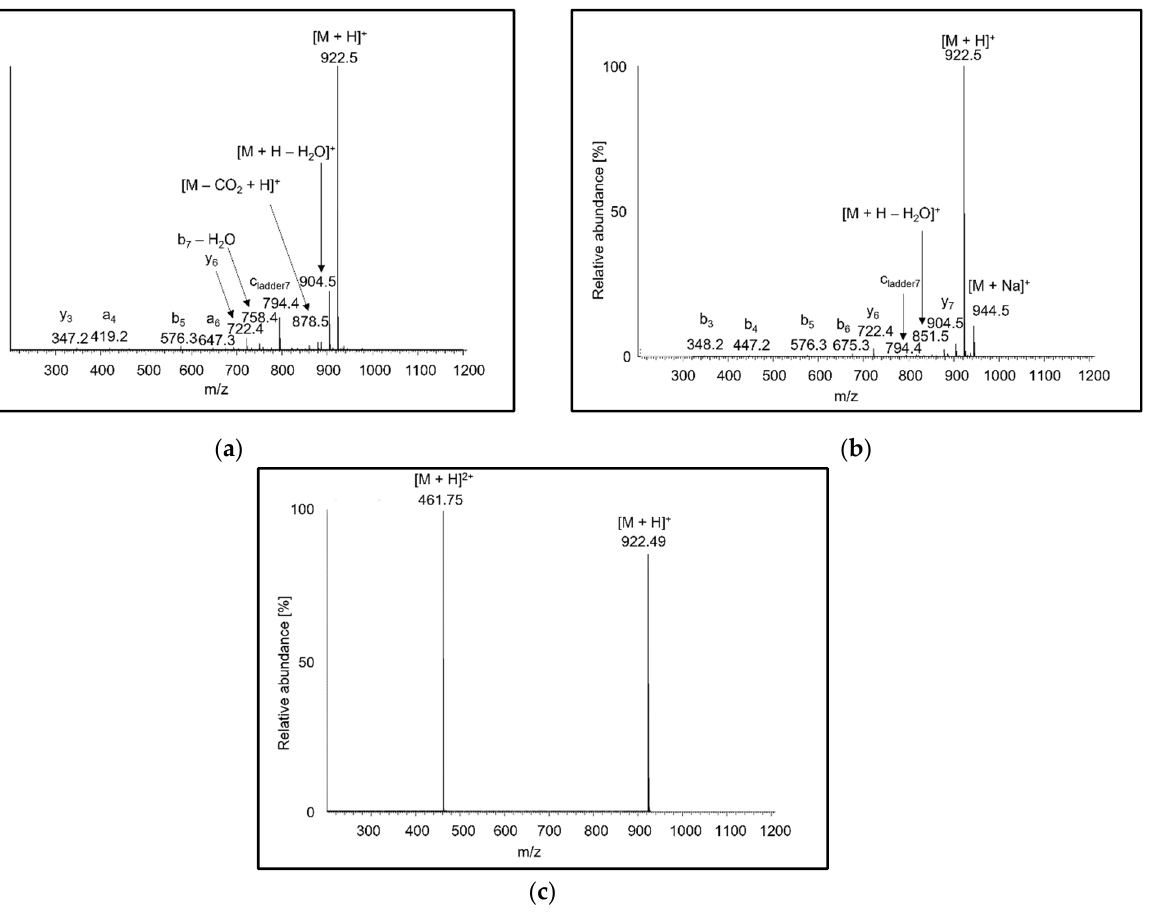
Figure 1. Full scan mass spectra of AEFVEVTF ionized by ( a ) atmospheric-pressure chemical ionization (APCI), ( b ) atmospheric-pressure photoionization (APPI), and ( c ) electrospray ionization (ESI) recorded in methanol/water (80:20 v/v).